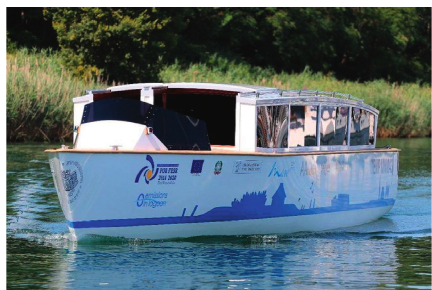
Figure 3: The prototype of the small passenger craft analysed in this study.